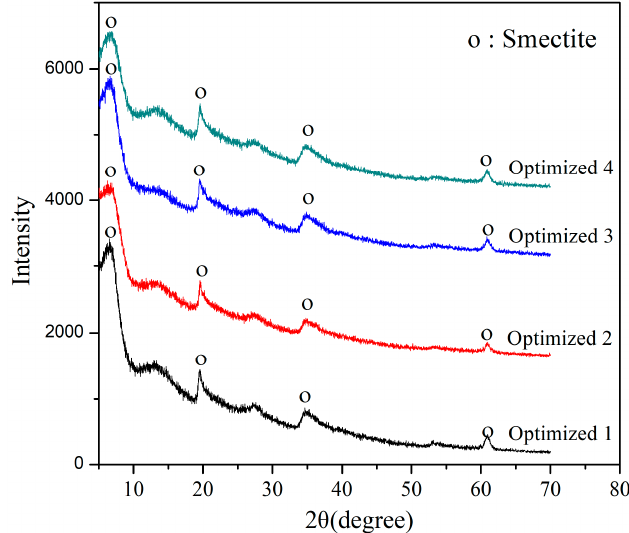
Figure 5. XRD analysis results for smectite samples employing optimal factors based on the Taguchi method. Table 7. Phase purity and yield of smectites synthesized under optimized conditions (unit: %). Sample No.